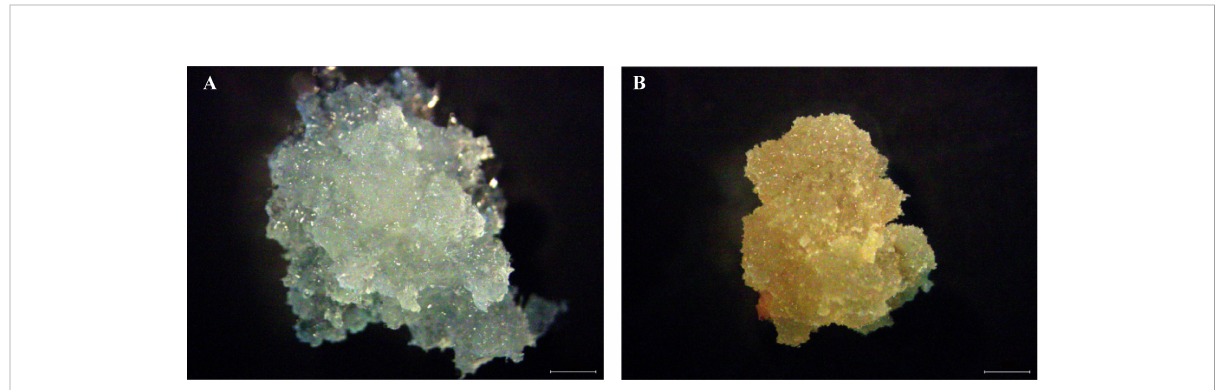
FIGURE 1 Embryogenic callus (EC) and non-embryogenic callus (NEC) in L. kaempferi . (A) EC. (B) NEC. Scale bar: